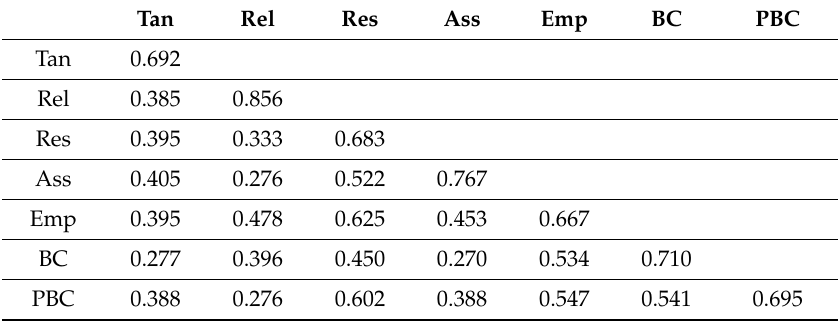
Table 2. Discriminant validity